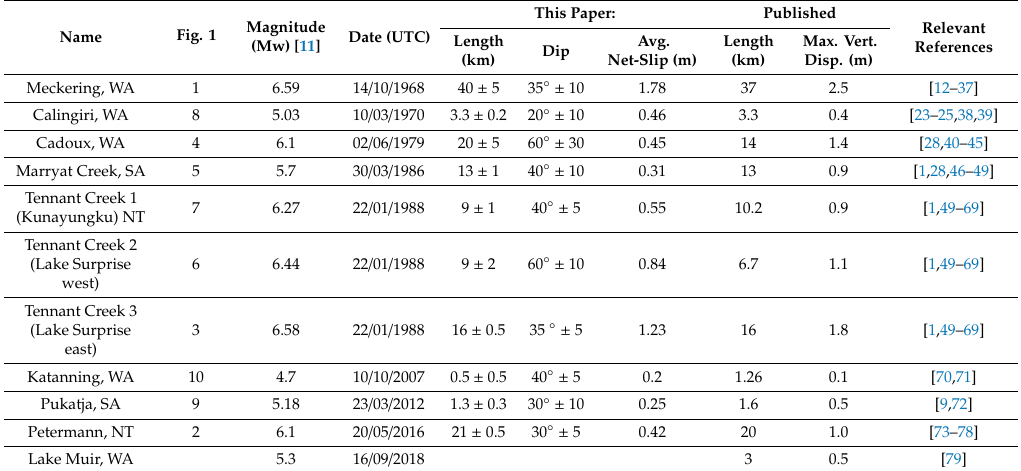
Table 1. Summary of known historic Australian surface rupturing earthquakes and relevant references.